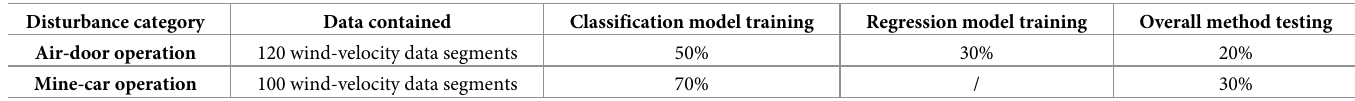
Table 3. Dataset